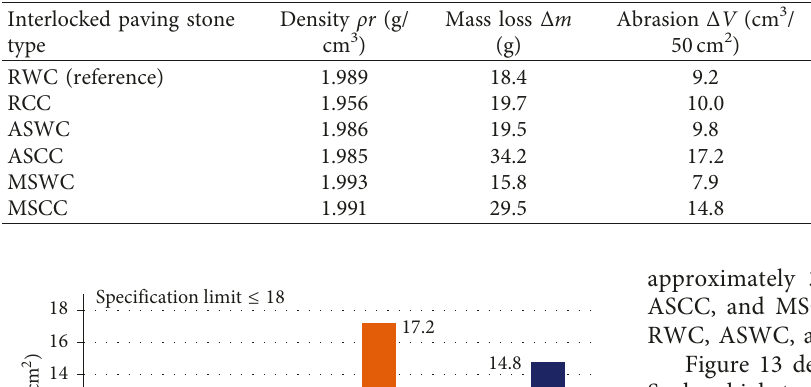
Table 19: Results of the abrasion test for the interlocked paving stones.